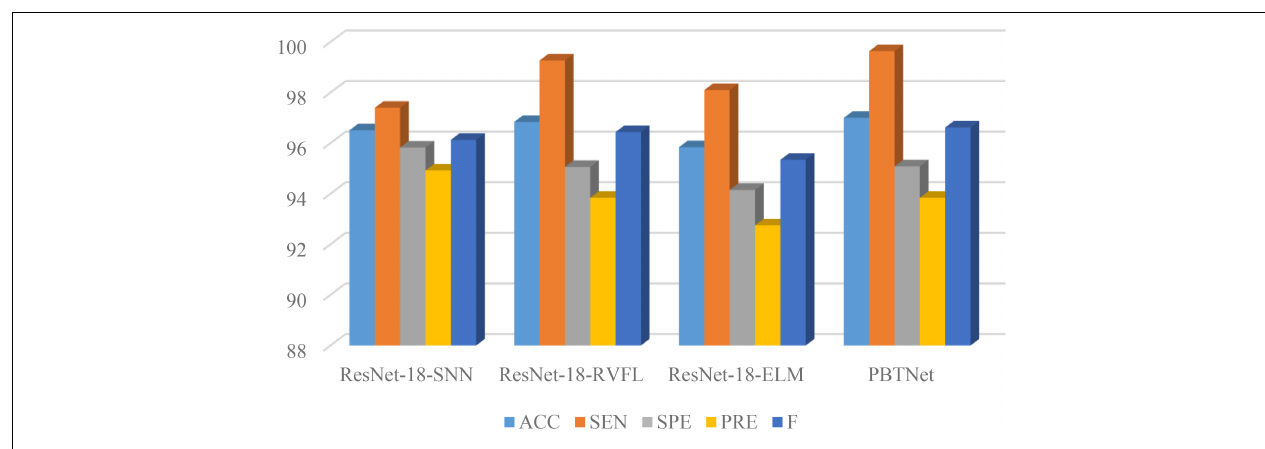
FIGURE 7 | Comparison of the four proposed models (unit: %).